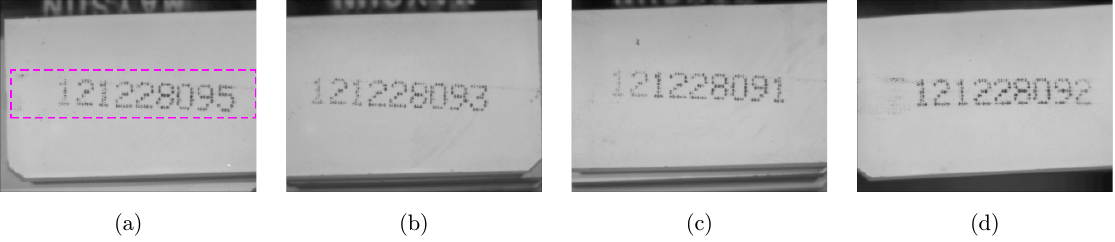
Fig. 2. Four online captured raw images For DMDC. (a) The raw image 1, (b) the raw image 2, (c) the raw image 3 and (d) the raw image 4.